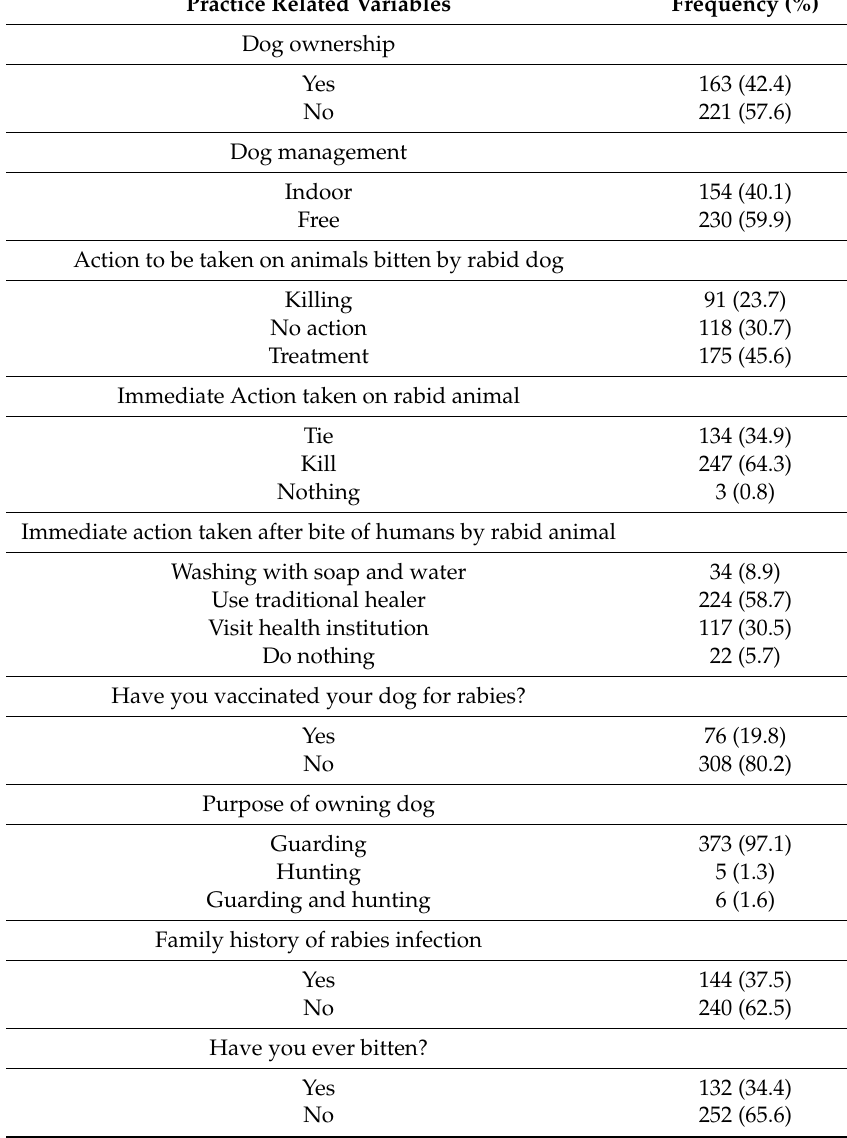
Table 6. Practices of the study participants towards (N = 384),